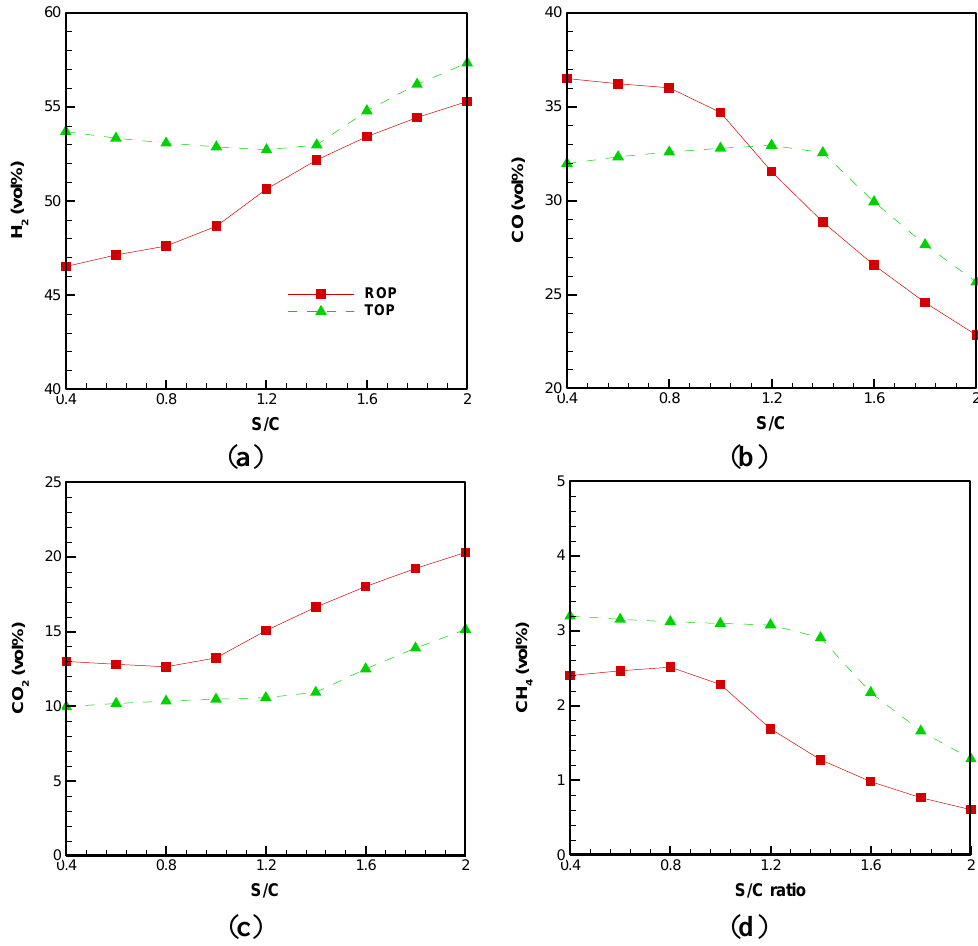
Figure 2. Effects of the S/C ratio on product distribution of ( a ) H 2 ; ( b ) CO; ( c ) CO 2 ; and ( d ) CH 4